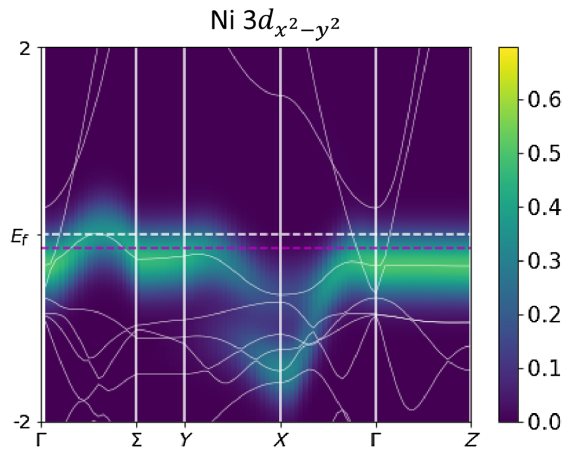
FIG. 9. Estimated Fermi energy shift for Nd 0 the parent compound NdNiO 2 is marked by the white dashed line, while the estimated E f for Nd 0 dashed